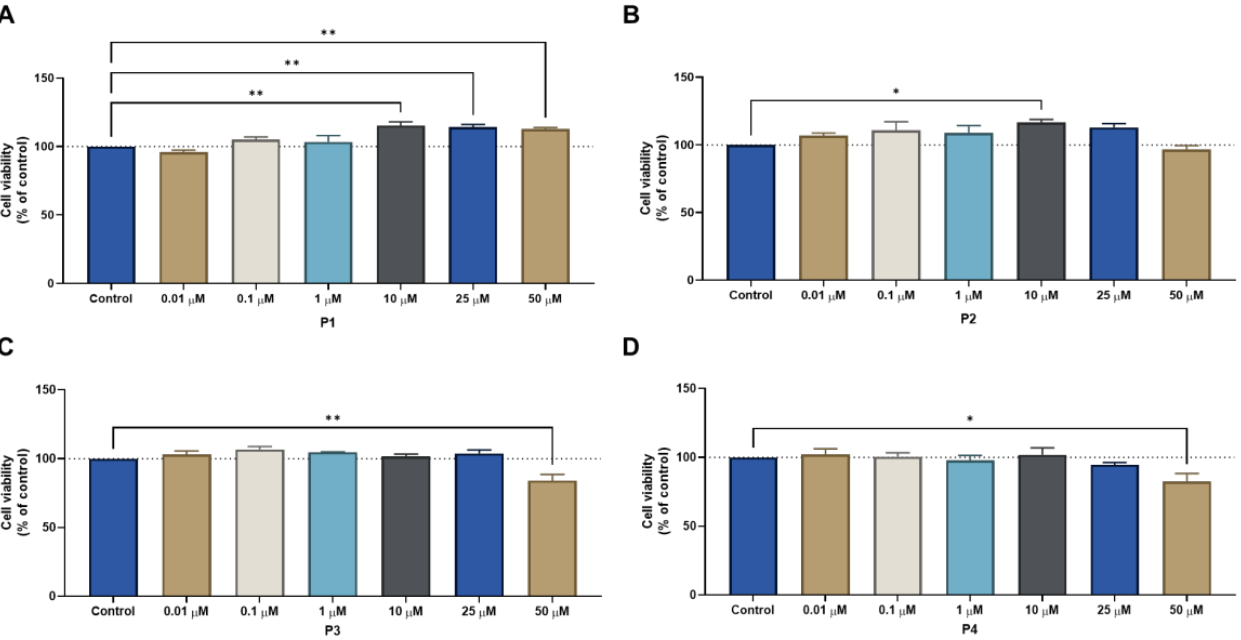
Figure 9. Cytotoxic results of MCF-7 after exposure to increasing concentrations of peptides ( A ) P1, ( B ) P2, ( C ) P3, and ( D ) P4 (0.01–50 µ M) for 48 h. Control cells were treated with 0.01% DMSO (vehicle). Cell viability was obtained using the MTT assay, and the results are given as the mean ± SEM ( n = 3). * Statistically significant vs. control (vehicle) at p < 0.05, ** statistically significant vs. control (vehicle) at p < 0.01.